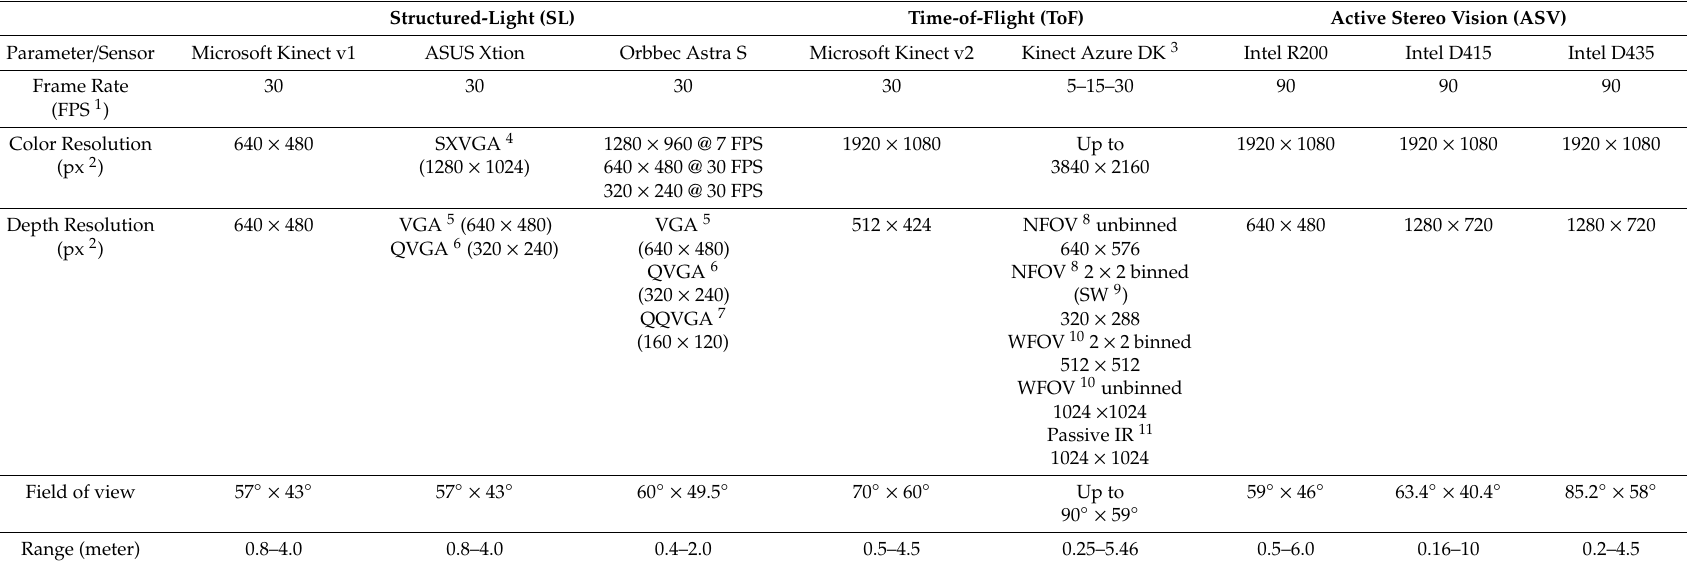
Table 3. Comparison of depth